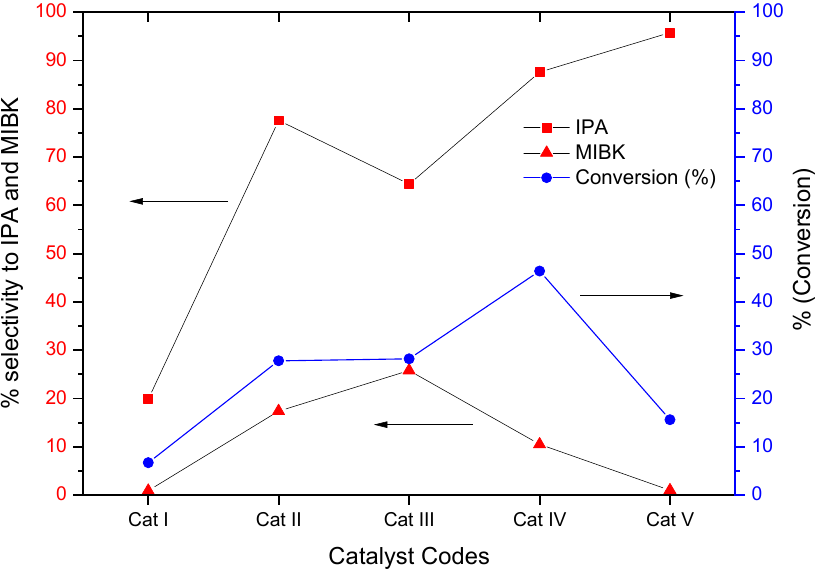
Figure 6. The conversion and selectivity as a function of Ru-loading. Reaction conditions: 0.25 g catalyst, t = 250 °C, H 2 /acetone mole ratio = 6:1.